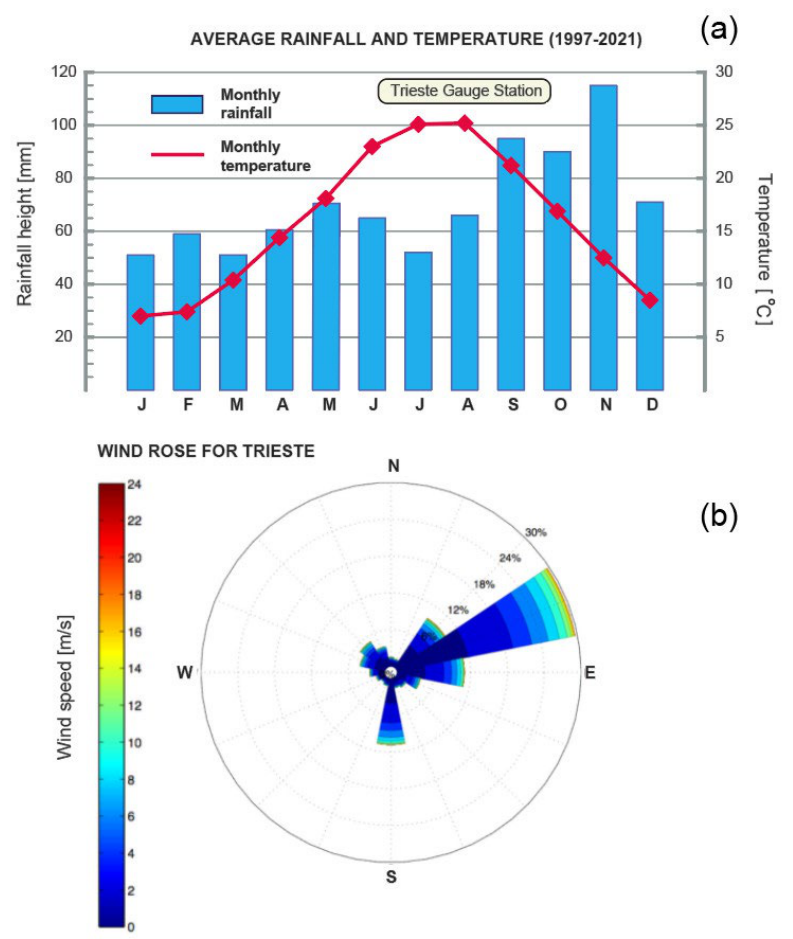
Figure 3. ( a ) Debeli Rt ič : climatograph constructed by averaging data recorded since 1997 at the Trieste meteorological station (Molo Bandiera, elev. 1 m a.s.l.); ( b ) Wind rose (Source: [31]).